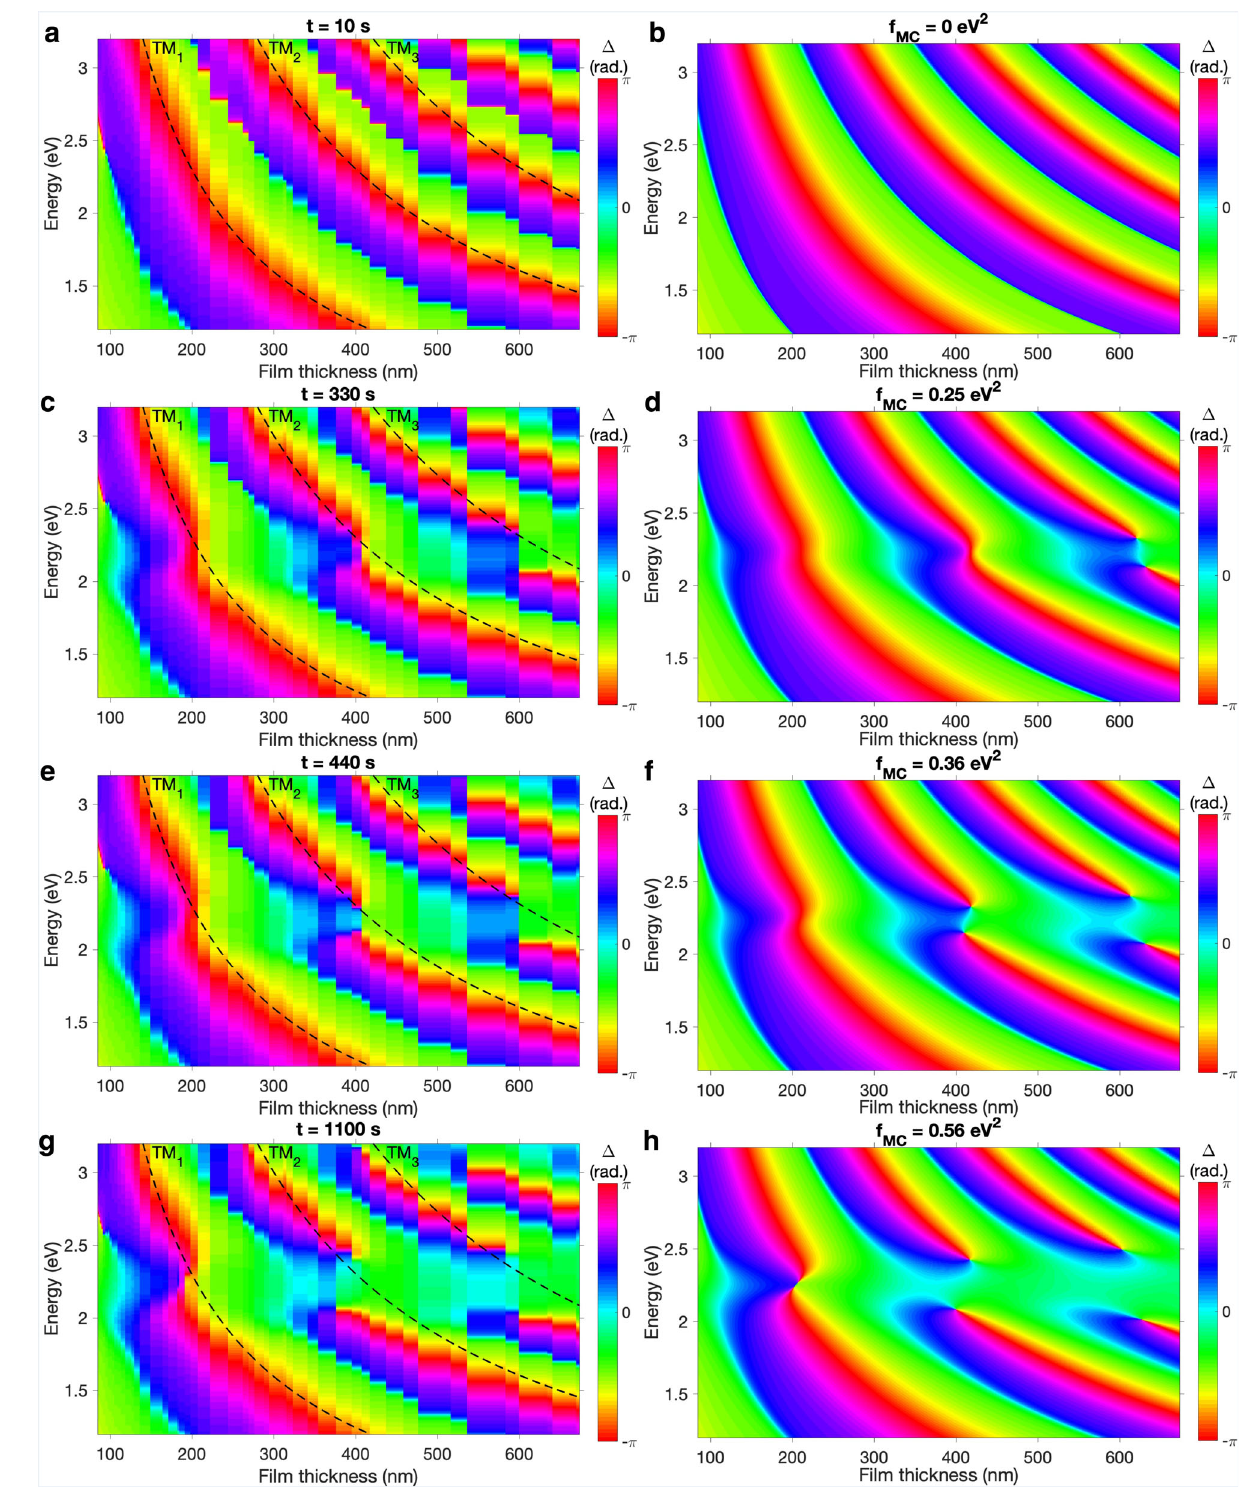
Fig. 3 Creation of phase singularities for a range of fi lm thicknesses. a , c , e , g Experimental and b , d , f , h calculated (Fresnel approach) dispersion plots constructed using the ellipsometric parameter Δ for SPI/MC fi lms over a range of thicknesses at fi xed angle θ = 65 ° . The MC concentrations were varied in experimental plots by UV exposure time ( a t = 10 s, c t = 330 s, e t = 440 s, g t = 1100 s) and in calculated plots by varying the Lorentz oscillator strength of MC ( b f MC = 0 eV 2 , d f = 0.25 eV 2 , f f = 0.36 eV 2 and h f = 0.56eV 2 ). The positions of the uncoupled TM modes are indicated by the black dashed lines in a , c , e , g